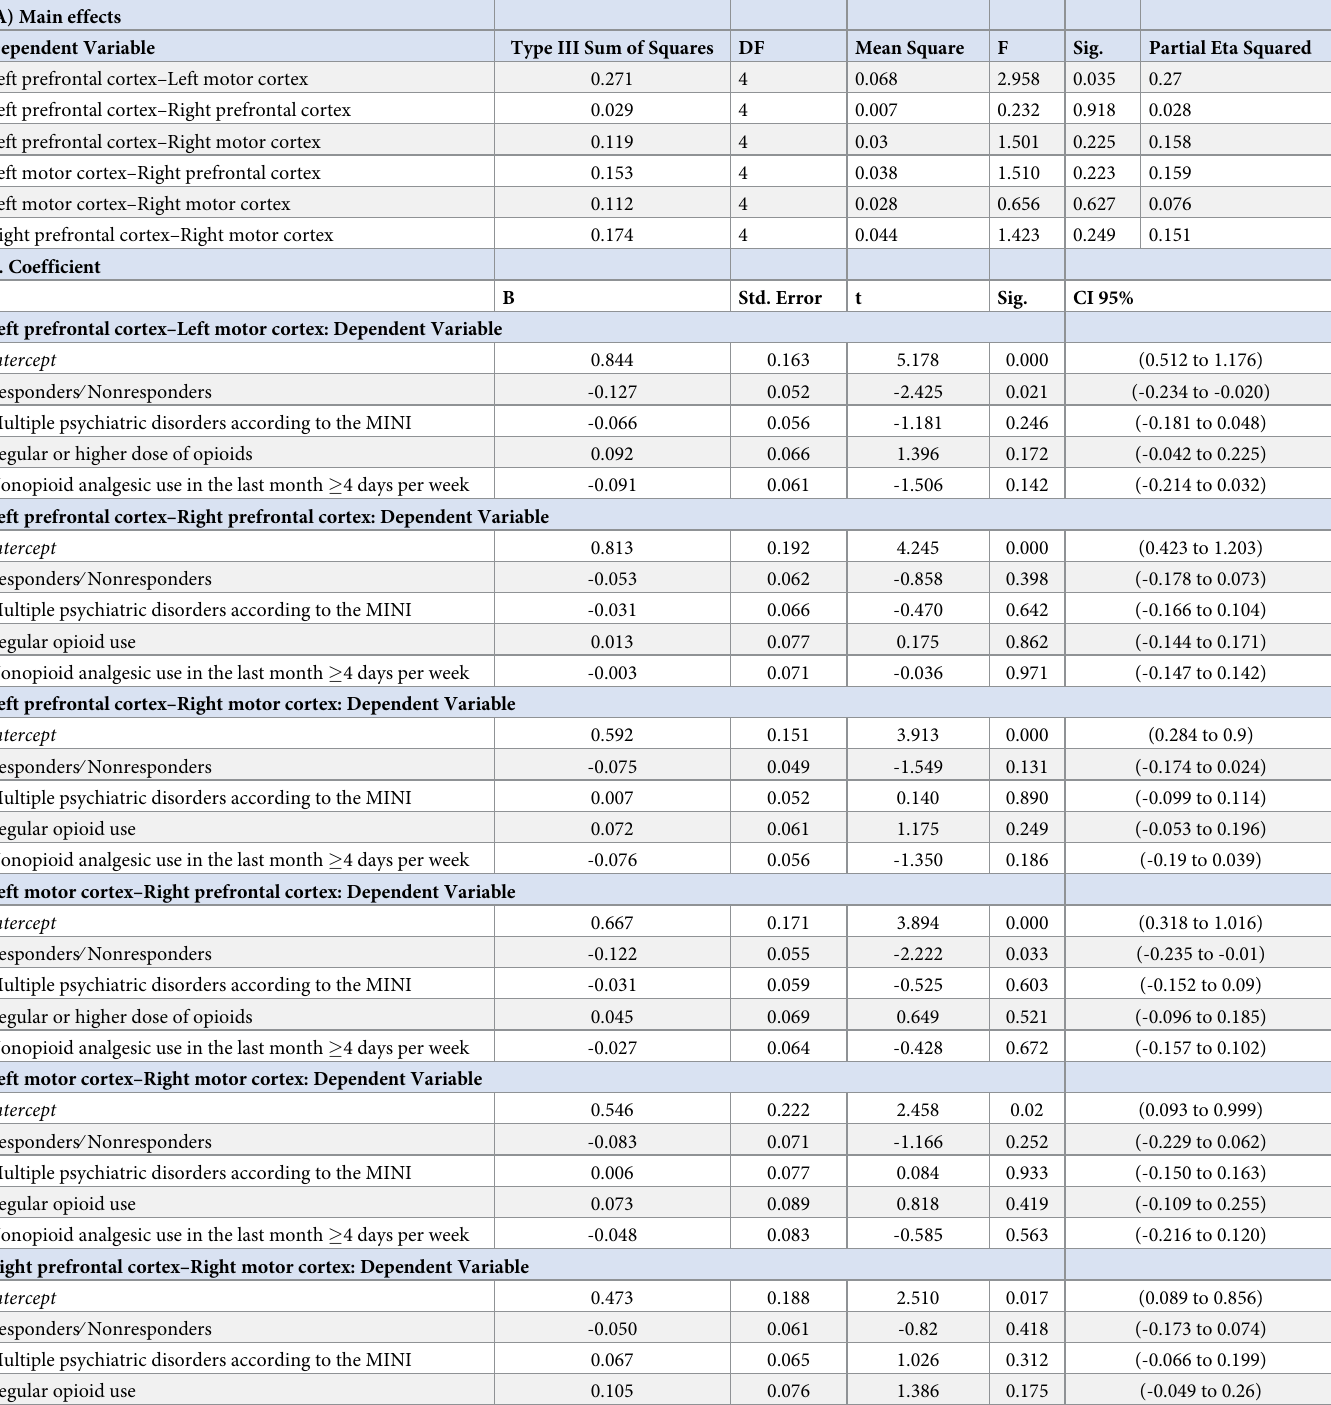
Table 3. MANCOVA analysis of the relationship between the FC according to the spectrum of responders or nonresponders according to change in NPS (0–10) during the CPM-test (n =